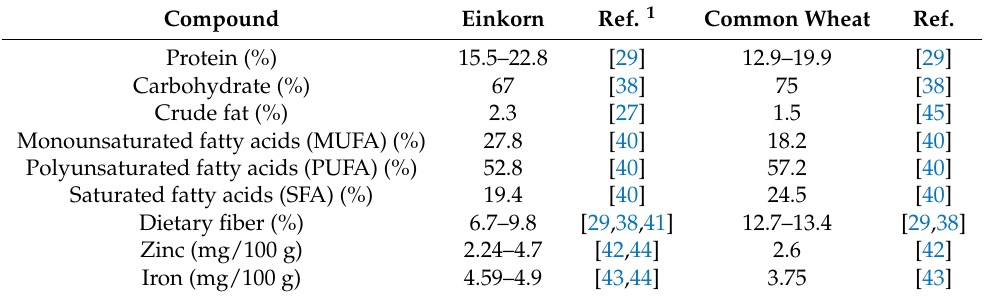
Table 1. Comparative composition of certain chemical constituents of einkorn and common